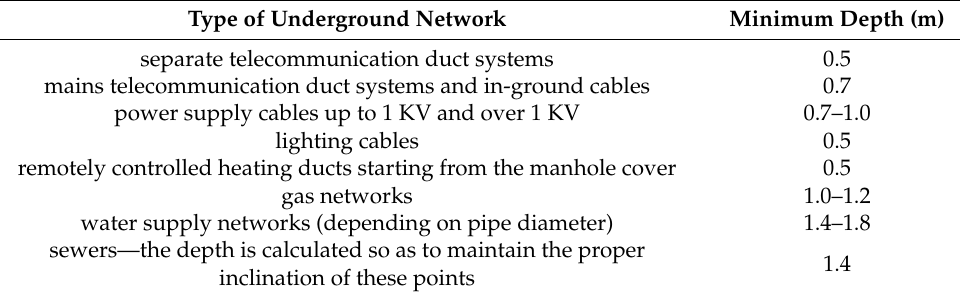
Table 2. Minimum depths of installing underground